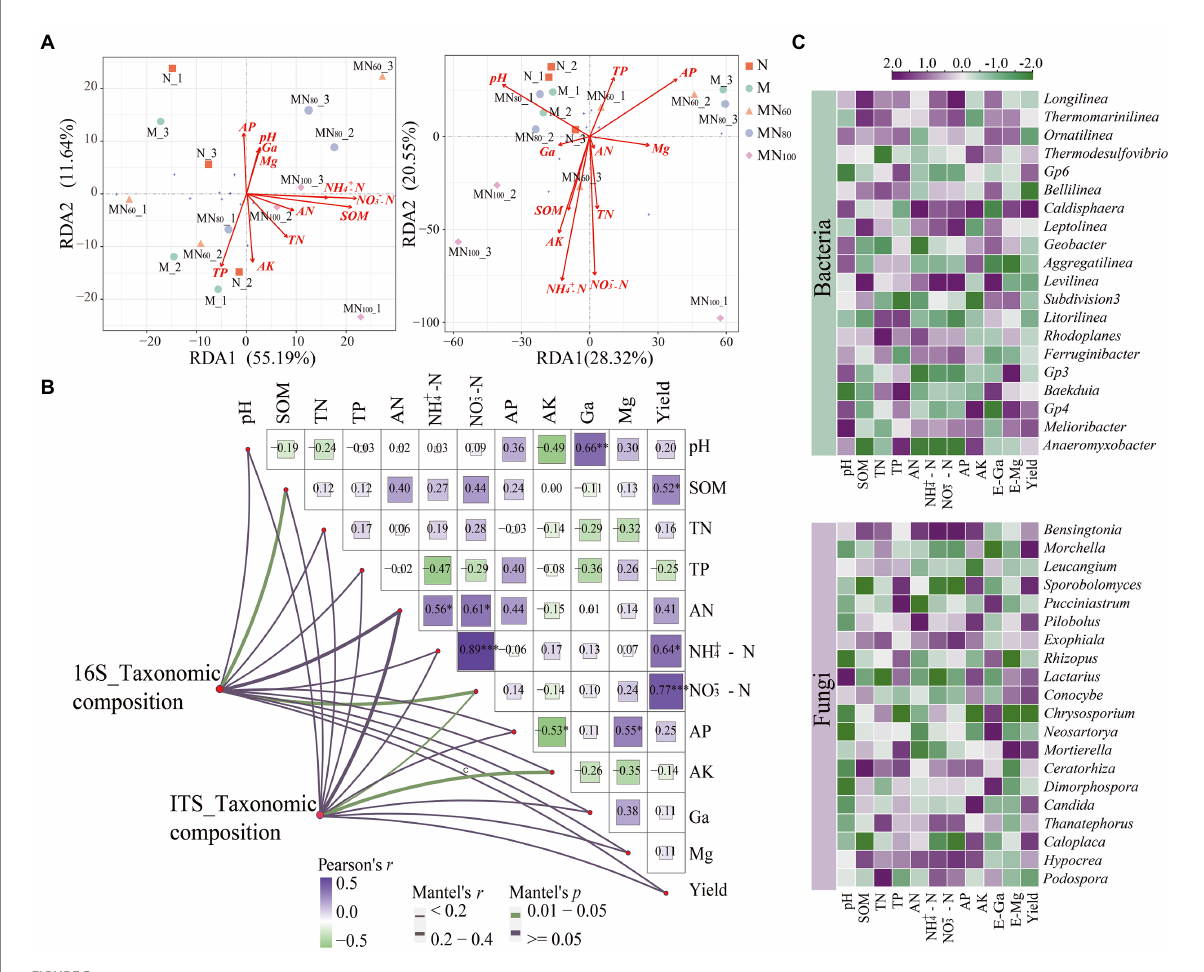
FIGURE 5 (A) RDA analysis of the effect of environmental factors on microbial composition. (B) Mantel test above with a Pairwise comparisons of environmental factors are shown, with a color gradient denoting Pearson’s correlation coefficient. Edge width corresponds to the Mantel’s R statistic for the corresponding distance correlations, and edge color denotes the statistical significance based on permutations. (C) Heatmap of the correlation between dominant microorganisms (genus level) and environmental factors based on Spearman correlation